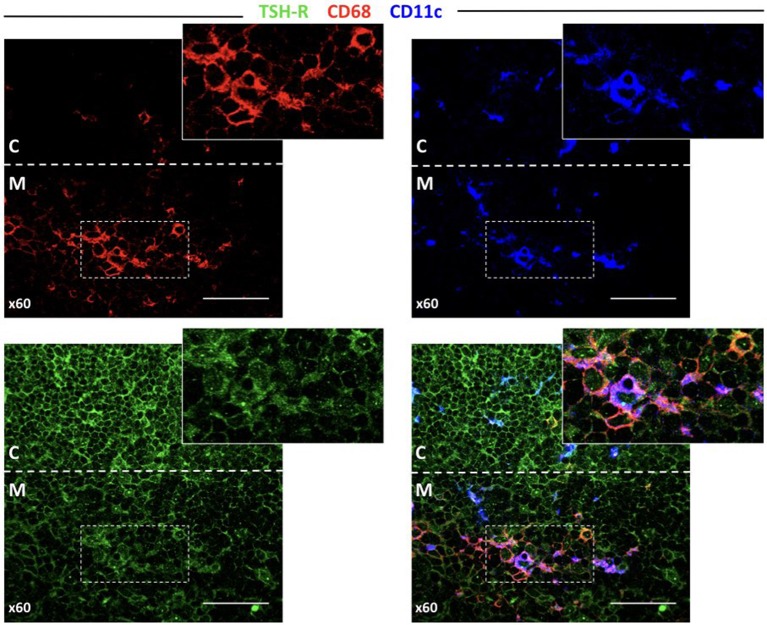
TSHR protein expression in the thymus detected by immunofluorescence. Abundant cells in the cortex that can be morphologically identified as thymocytes and other larger cells (left bottom panel) are positive for TSHR visualized in the green channel. The bottom-right pictures combine the macrophage marker, CD68, and the dendritic cell marker, CD11c, reveal some orange-yellow cells that correspond to macrophages that contain TSHR. There are also some violet cells (probably DCs), for which is more difficult to identify TSHR staining but some cytoplasmic light blue fluorescence (from the overlapping of dark blue and green), is observed. The arrow points to a macrophage visible in all micrographs except the CD11c staining, and the arrowhead points to a dendritic cell visible in all micrographs except in the CD68 staining.